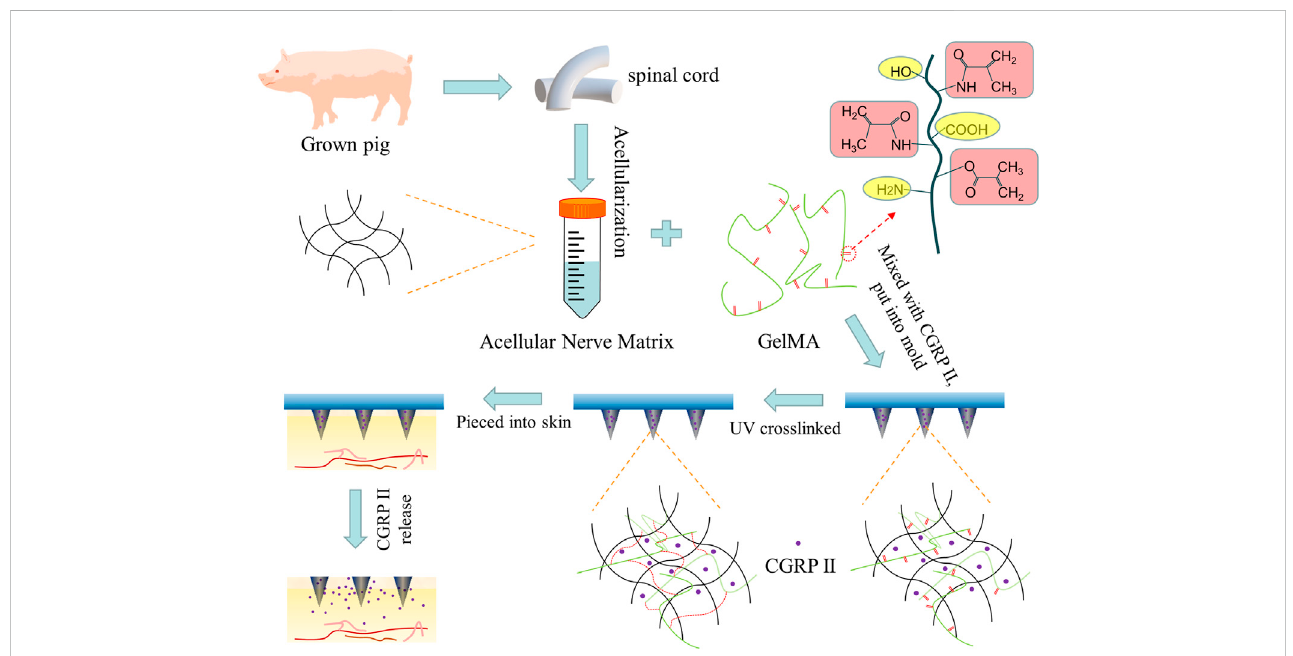
FIGURE 1 Scheme of the design of biodegradable microneedle patch fabricated by double-network GelMA-ACNM hydrogel for transdermal drug delivery.